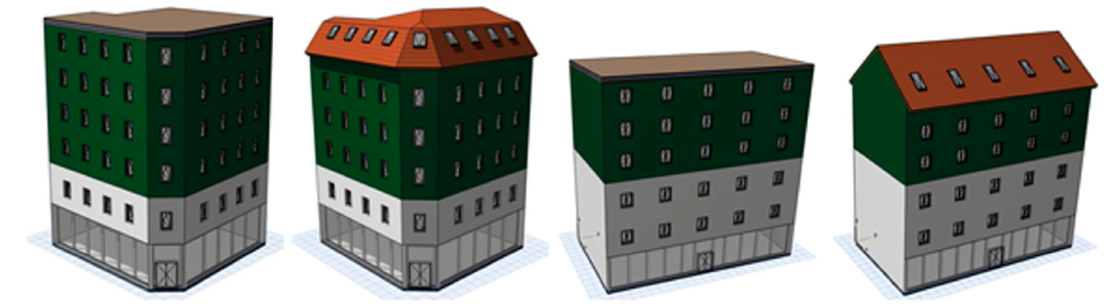
Figure 6. Theoretical vertical extensions of the case study buildings with the floor extensions shown in green with flat and slanted roofs [53,54].